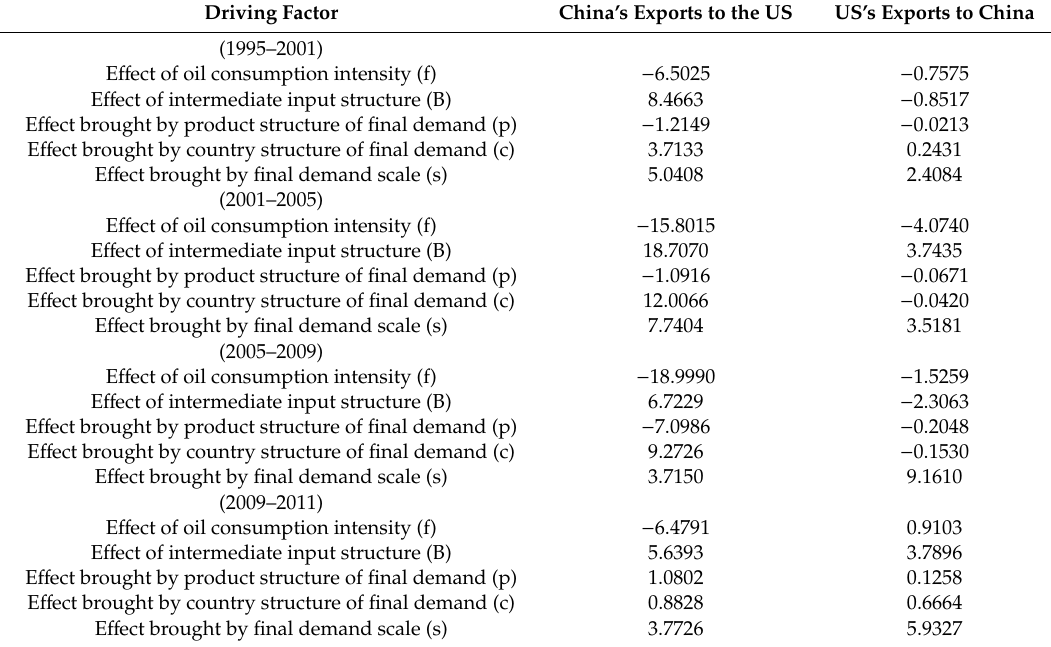
Table A8. The driving forces of virtual oil consumption changes